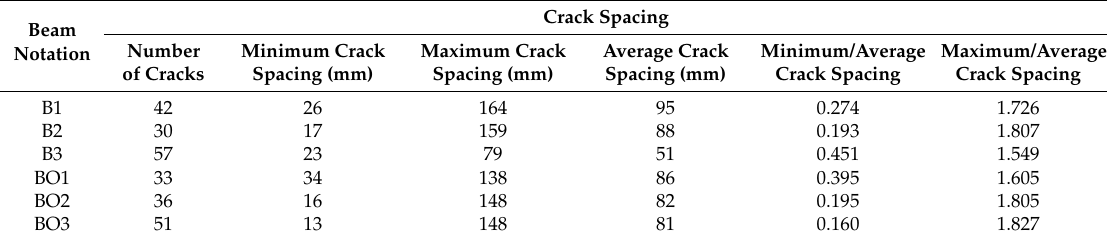
Table 7. Crack spacing at ultimate load.